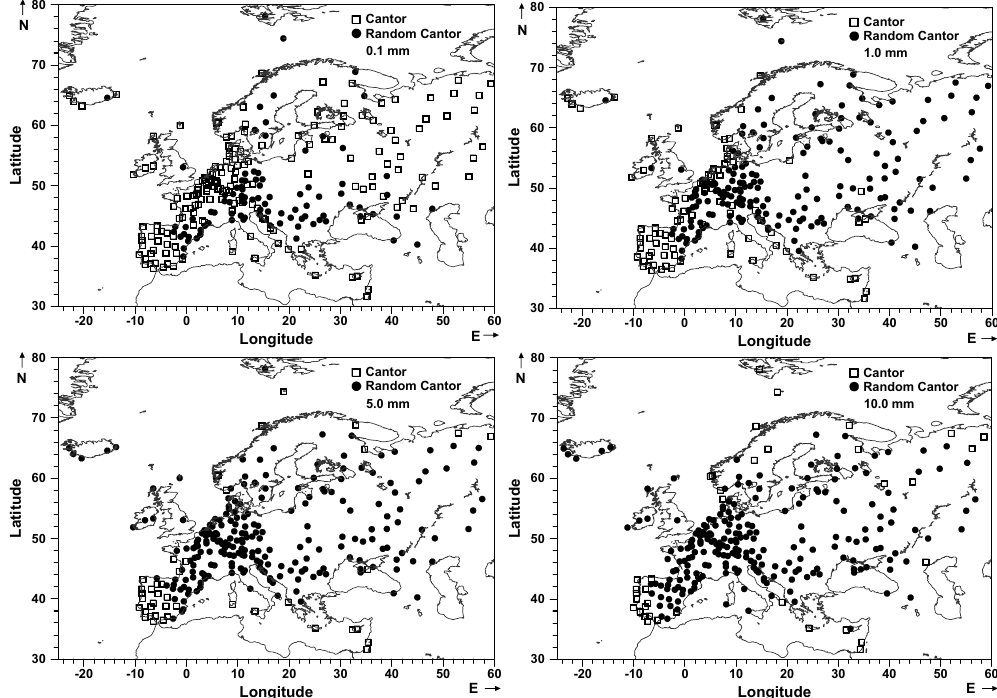
Fig. 4. Spatial distribution of sites where lacunarity curves are best fitted to Cantor (open squares) or random Cantor (solid circles) sets.